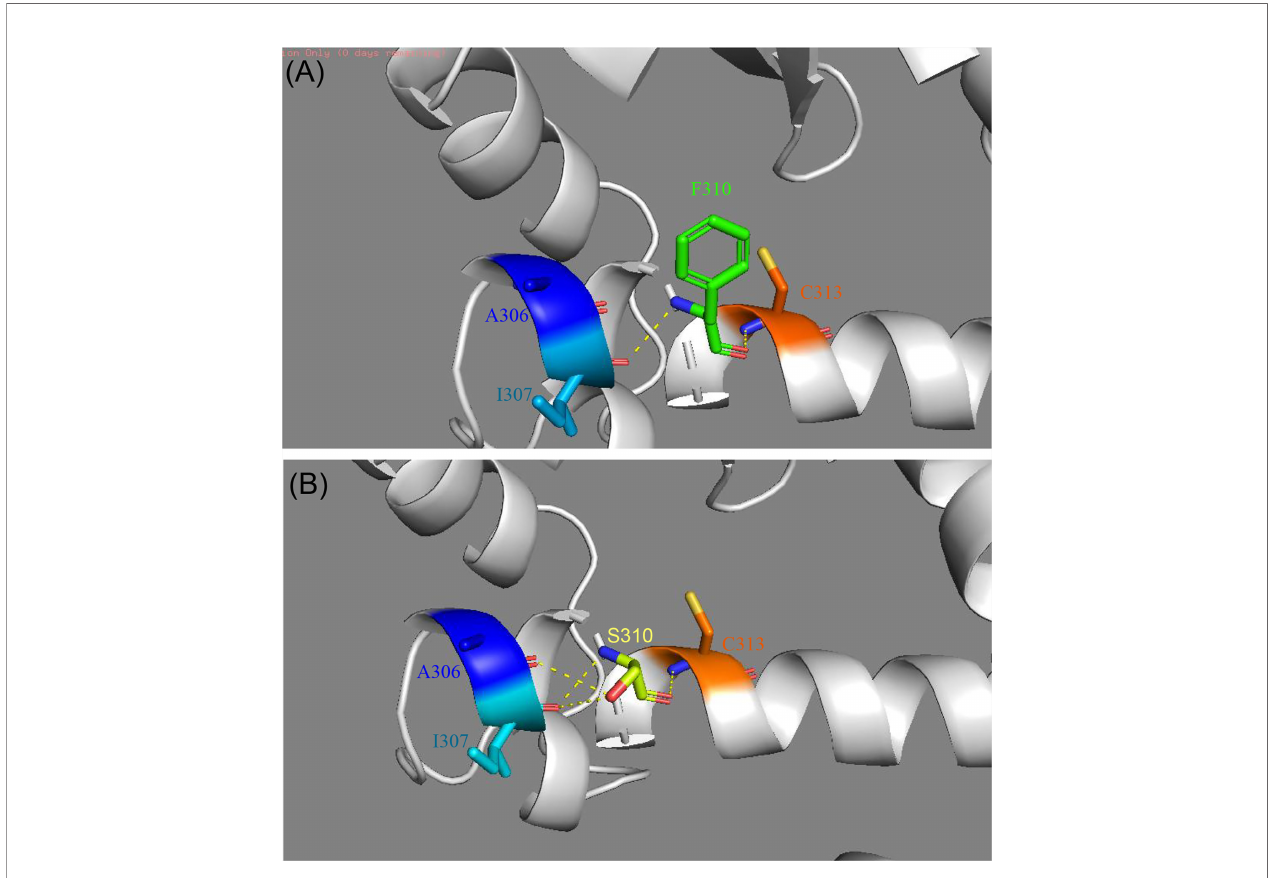
FIGURE 3 | Comparison of the structure of modeled wild-type (A) and mutant PPAR g proteins (B) established by Swiss-Model. (A) The crystal structure of the wild- type PPAR g protein shows interactions between F310 and I307 and C313. (B) The crystal structure of the mutant PPAR g protein suggests that the F310S mutation alters the local hydrogen bond network of helix 3. Two new hydrogen bonds were formed after the F310S mutation, connecting to I307 and